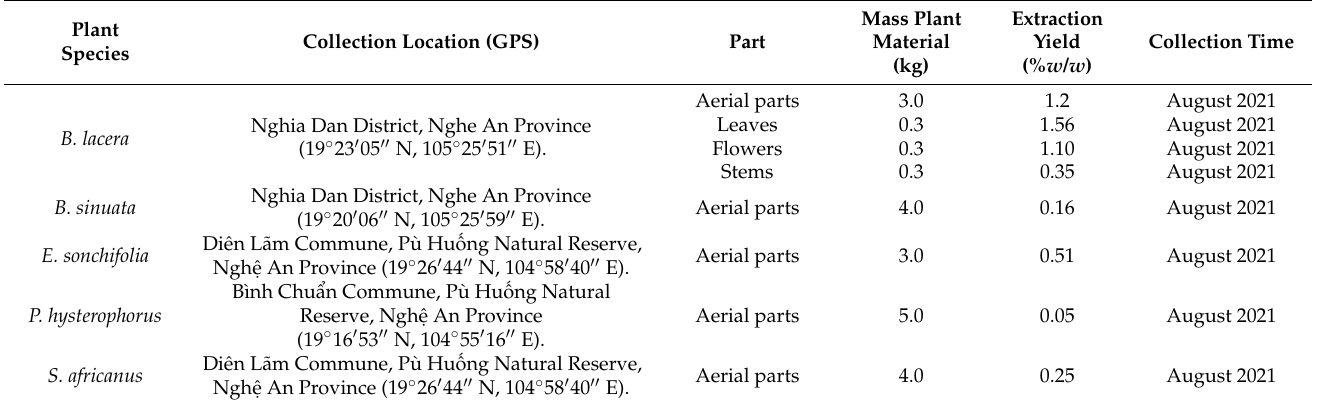
Table 7. Details for collecting essential oils of Blumea lacera , Blumea sinuata , Emilia sonchifolia , Parthe- nium hysterophorus , and Sphaeranthus africanus